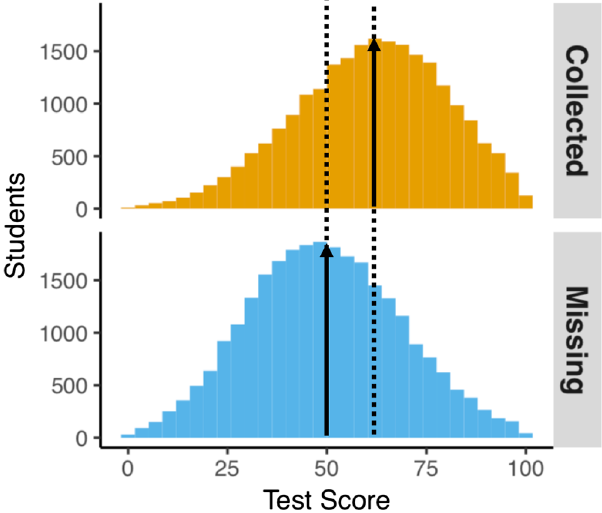
FIG. 1. Simulated distributions of missing and collected data with means indicated to illustrate data that are not